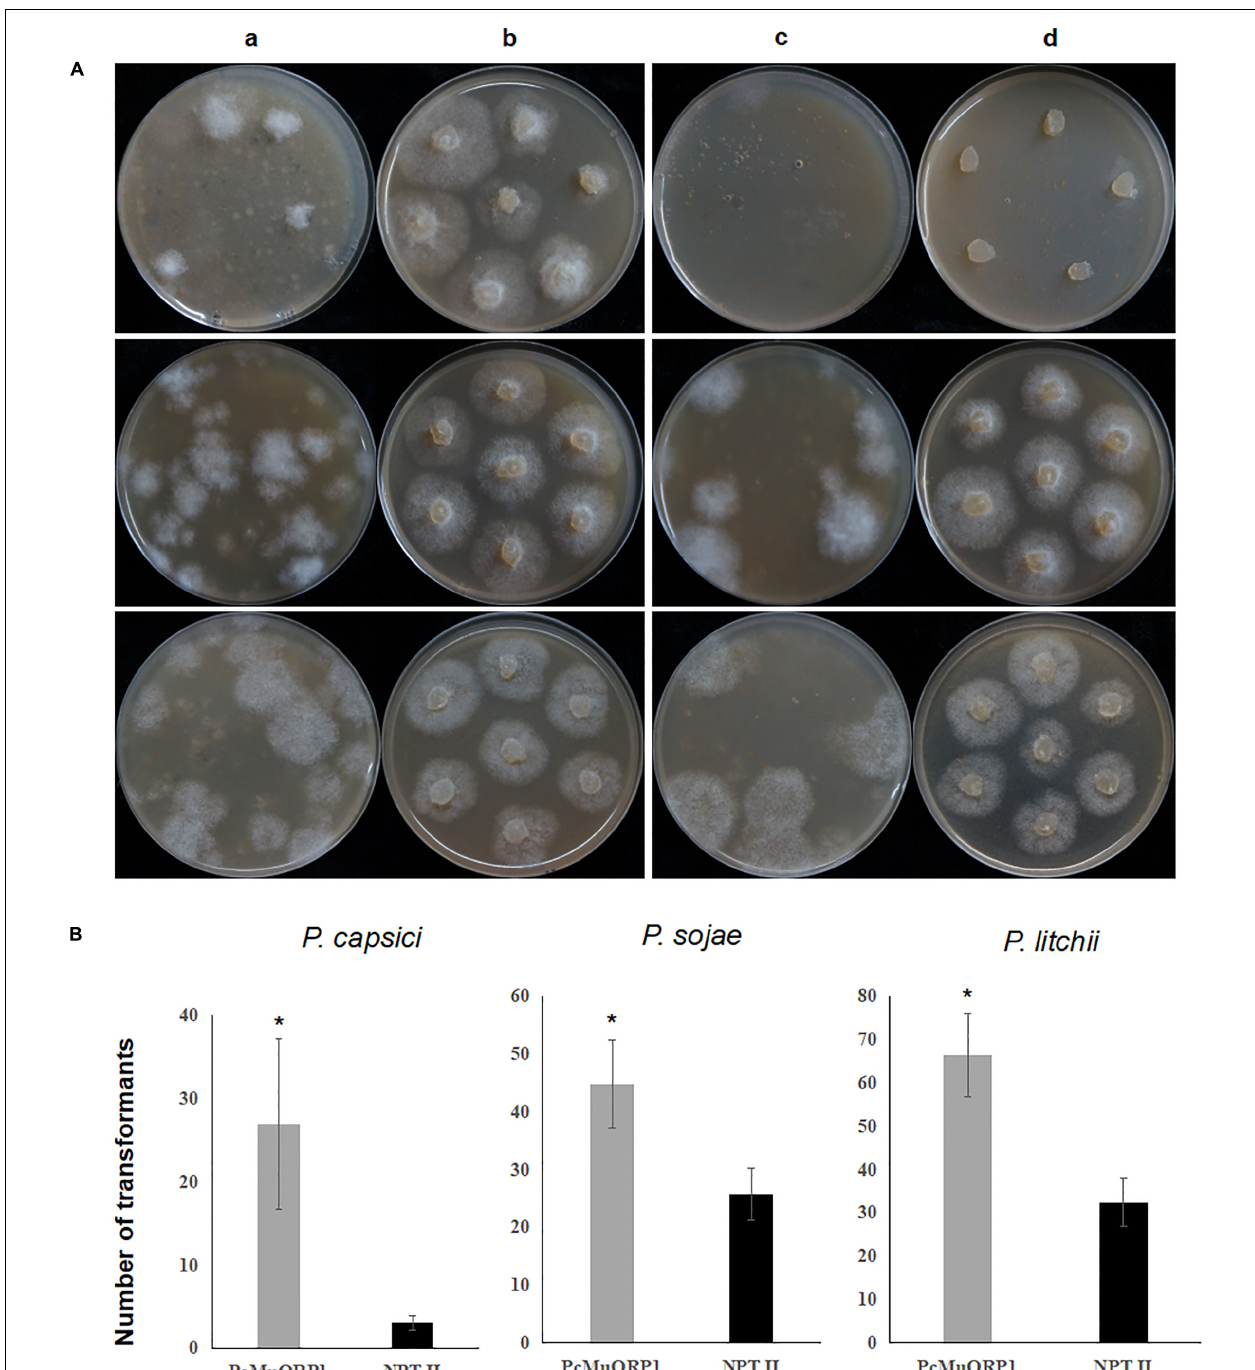
FIGURE 3 | Screening efficiency in three Phytophthora species using two different selection markers, PcMuORP1 and NPT II . (A) Transformant colonies of P. capsici (top), P. sojae (middle) and P. litchii (bottom) screened using either oxathiapiprolin or G418, respectively. a: Transformant colonies ( PcMuORP1 ) after 3 days of culture on V8 medium amended with 0.01 µ g/ml oxathiapiprolin during the second screening, b: Subcultured colonies from the second screening after 2 days (3 days for P. sojae and P. litchii ) of culture on V8 medium amended with 0.01 µ g/ml oxathiapiprolin during the third screening, c: Transformant colonies ( NPT II ) after 3 days of culture on V8 medium modified with 50 µ g/ml G418 during the second screening, d: Subcultured colonies from the second screening after 2 days (3 days for P. sojae and P. litchii ) of culture on V8 medium modified with 50 µ g/ml G418 during the third screening. (B) Numbers of transformants recovered from 1 ml of protoplasts (4.5 × 10 6 per milliliter for of P. capsici ; 1.5 × 10 6 per milliliter for P. sojae and P. litchii ). Values represent the mean ± SD of three biological replicates derived from three independent experiments ( n = 4), and asterisks denote significant difference from NPT II . ∗ p < 0.05.